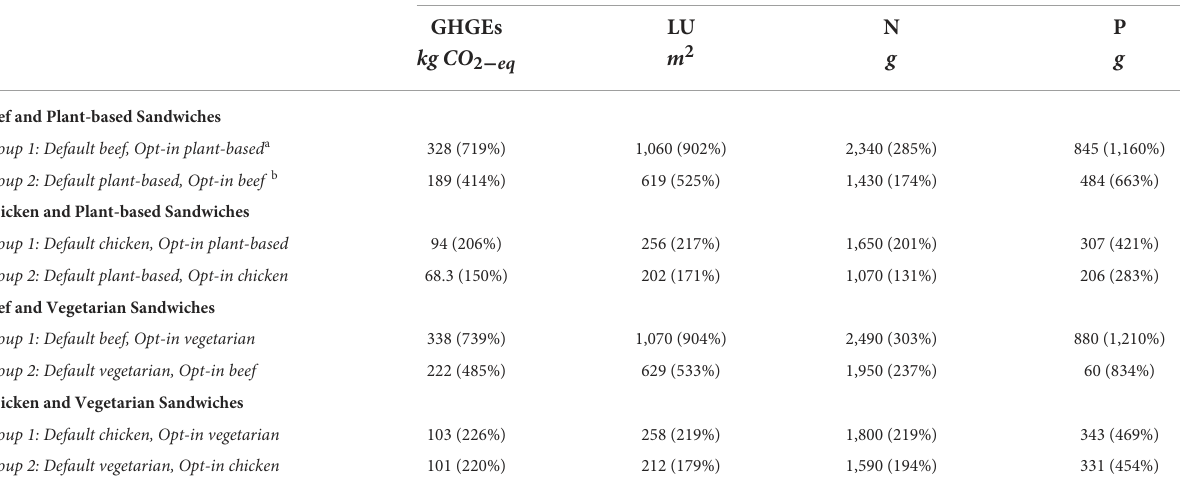
TABLE 5 Estimated environmental impact in terms of GHG emissions, land use (LU), blue water (BW), nitrogen (N), and phosphorus (P) use for hypothetical 100-person events at a college